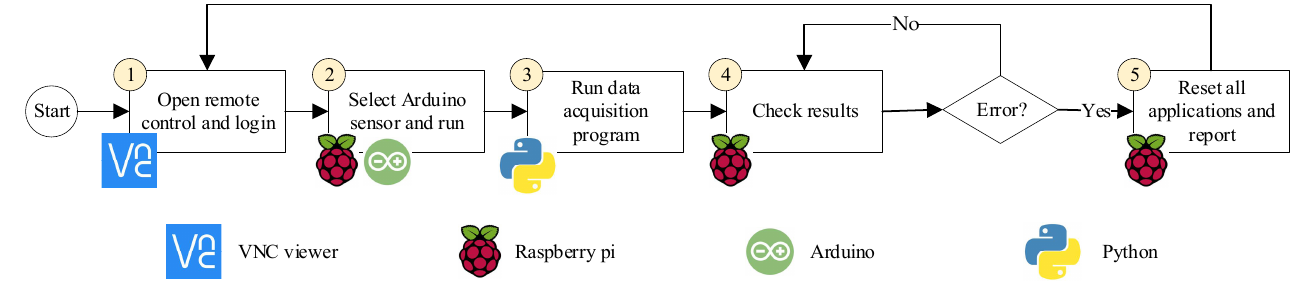
Figure 8. Process to automate (As − Is).